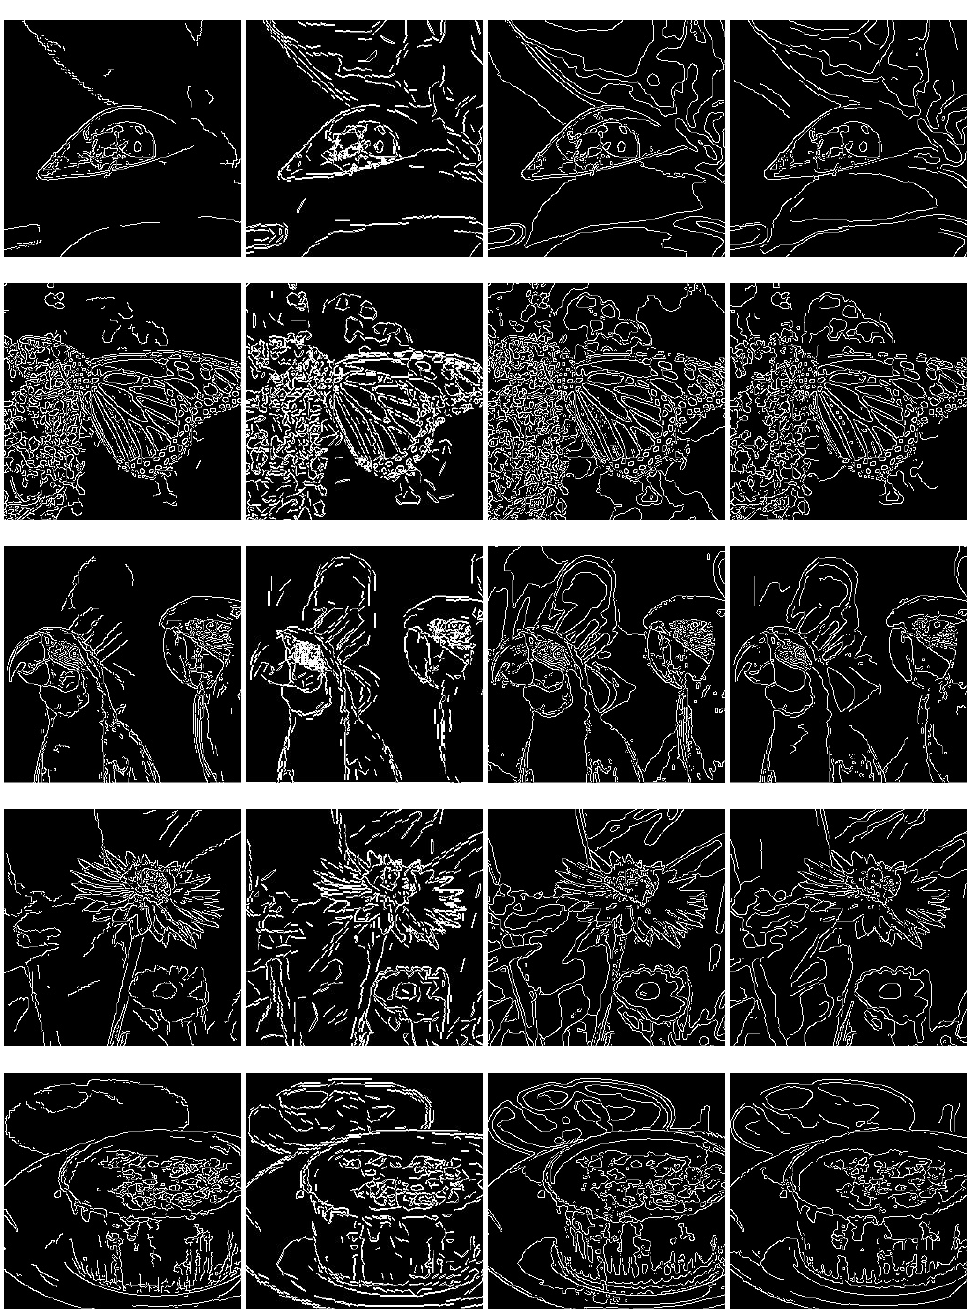
Figure 10. The results of edge detection by different methods: first column—Canny, second column—wedgelets2, third column—k-Means, fourth column—local k-Means